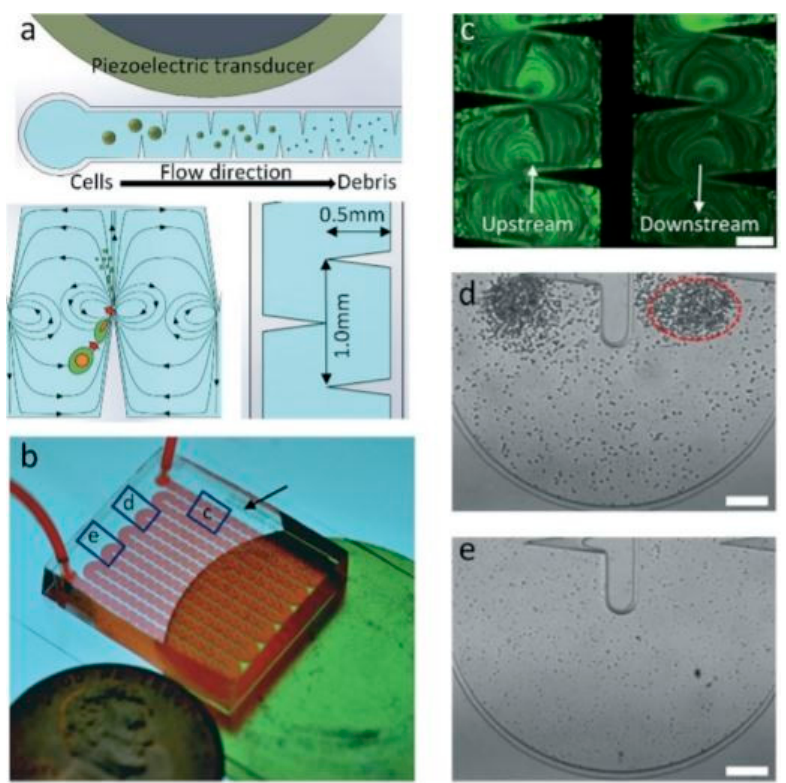
Figure 14. Design and concept of the sharp-edge-based acoustofluidic device for cell lysis utilized in [56]. ( a ) Schematic overview of the mechanism of the acoustofluidic lysis device. Sharp-edged structures are constructed on the sidewalls of the channels. ( b ) The device is composed of a serpentine channel with a large number of sharp-edged structures, an acoustic transducer, and a thin glass substrate. ( c ) Comparison of the cell density downstream and upstream of the channel. Image ( d ) upstream and ( e ) downstream the channel. Adapted with permission from [56]. Copyright 2019 Royal Society of Chemistry.